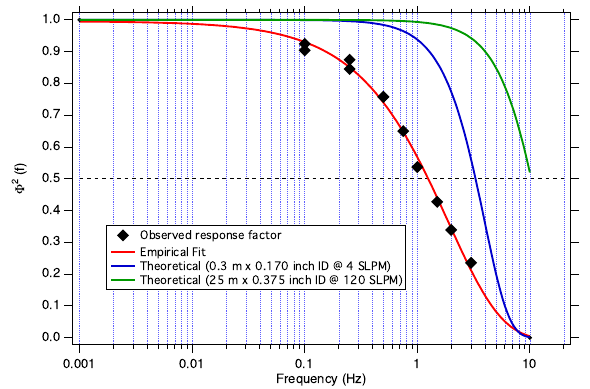
Fig. 7. Response ratio 8 2 (f ) for the APIMS inlet and Nafion dryer as a function of frequency. The red curve represents a least-squares fit to a two-parameter empirical function of the form 8 2 (f ) = exp ( − af b ) , where a = 0 . 557 and b = 0 . 917. Instrument response at 0.001Hz and 10Hz is assumed to be 1 and 0, respec- tively. The intersection of the horizontal line with the curve shows a half-power frequency of ≈ 1Hz. Also shown are theoretical at- tenuation for a 0.3m straight section of 0.17 inch ID tubing @ 4StdLmin − 1 and a 25m straight section of 0.375 inch ID tubing @ 120StdLmin − 1 (Lenschow and Raupach,